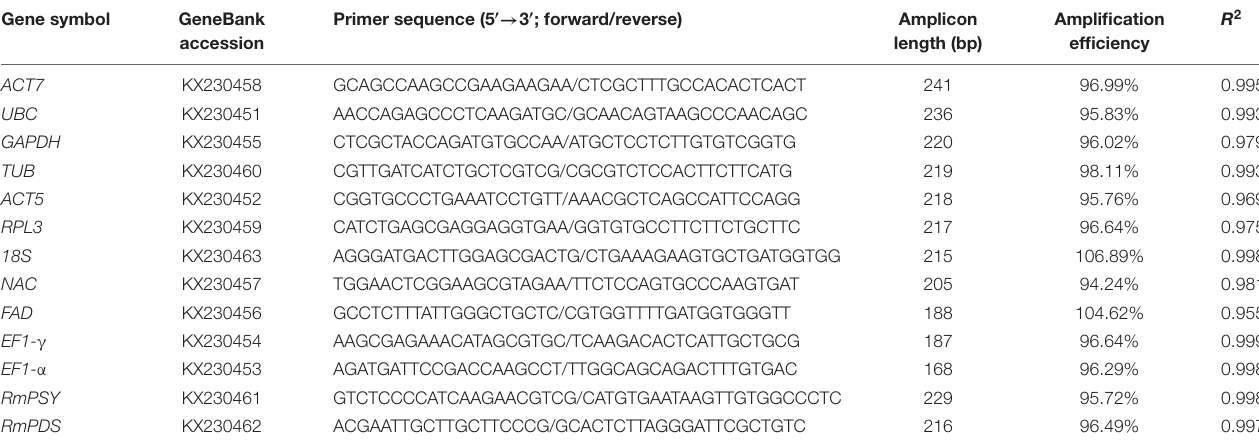
TABLE 1 | Candidate reference genes and different parameters derived from the qRT-PCR analysis. Gene